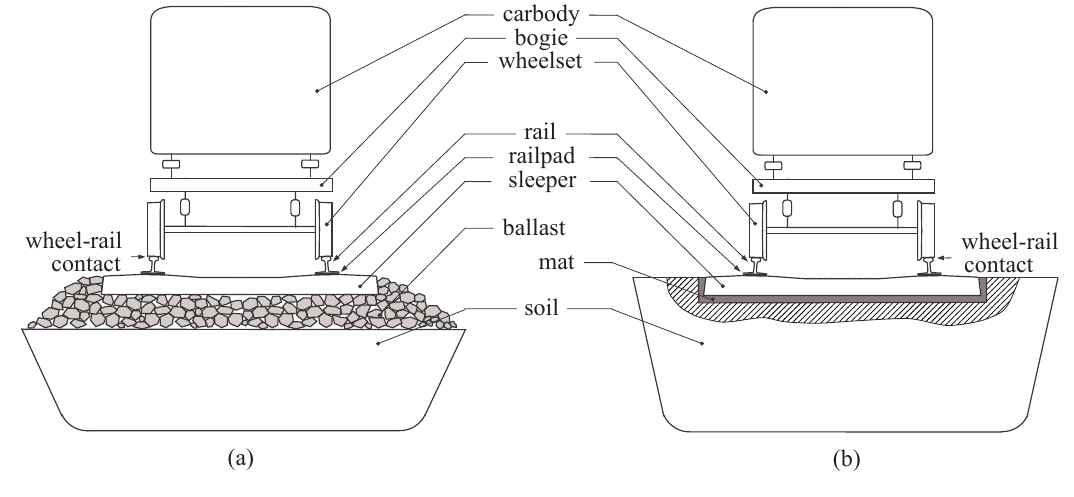
Figure 3. Vehicle/track main components (longitudinal view). ( a ) Ballasted track; ( b ) Slab